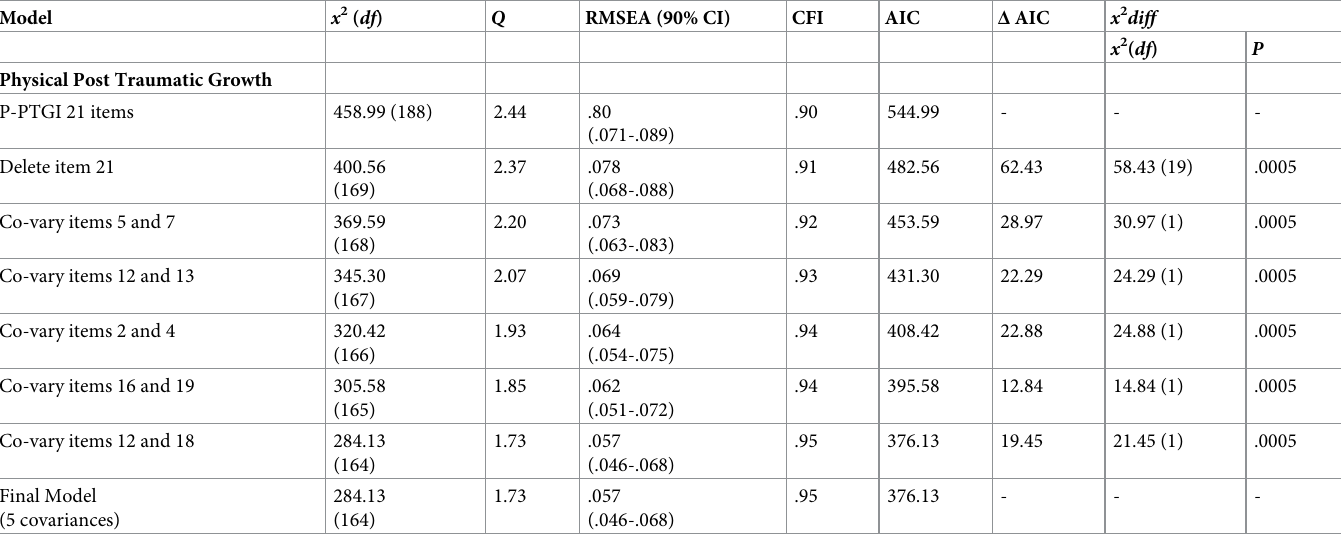
Table 3. Confirmatory factor analysis models for P-PTGI (Dataset